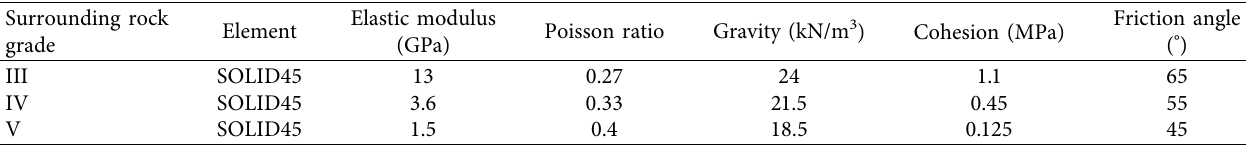
Table 7: Physical and mechanical parameters of surrounding rock.